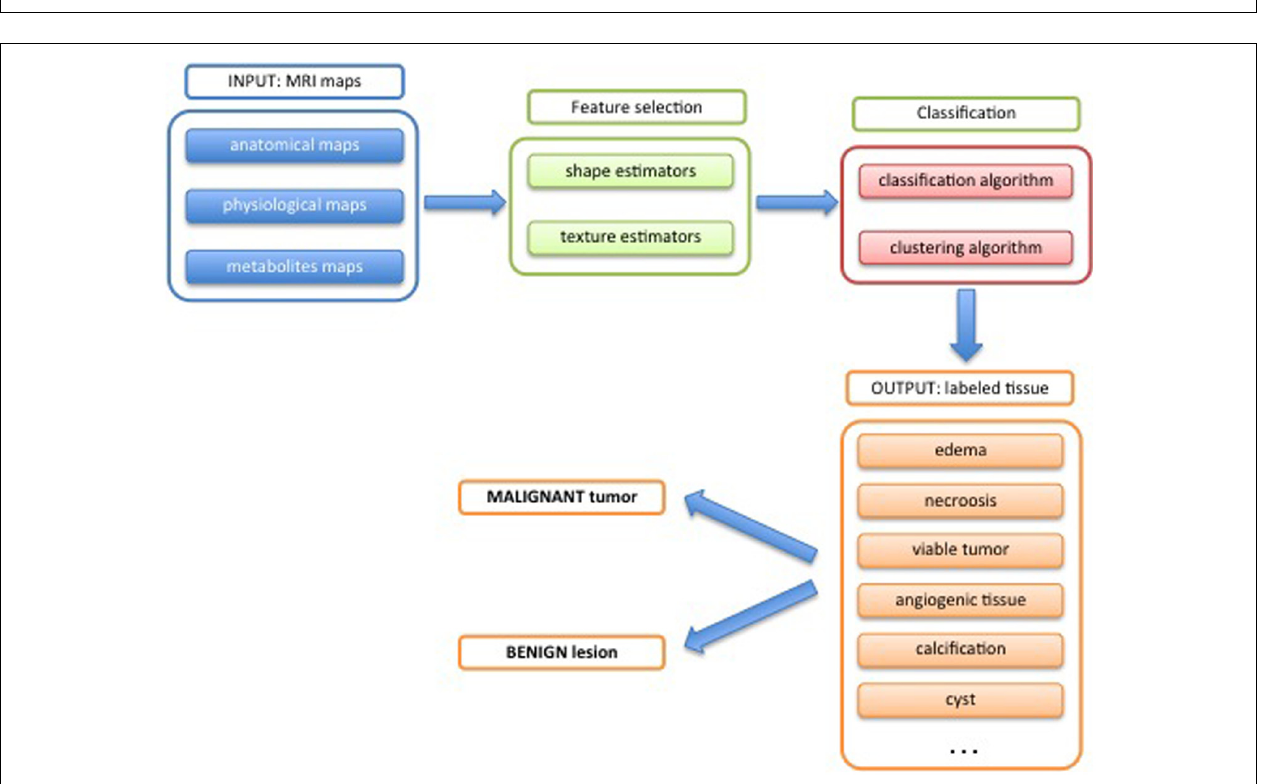
FIGURE 9 | Schematic workflow of the quantification process